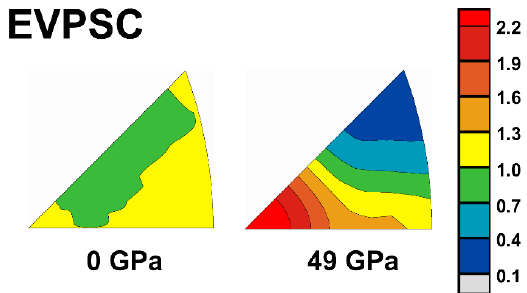
Figure 6. Activity of slip systems in EVPSC simulation. {110}〈11̅0〉 and {100}〈011〉 slip systems are activated with a ratio of 70:30 and gradually reach 100:0 at ~50 GPa .